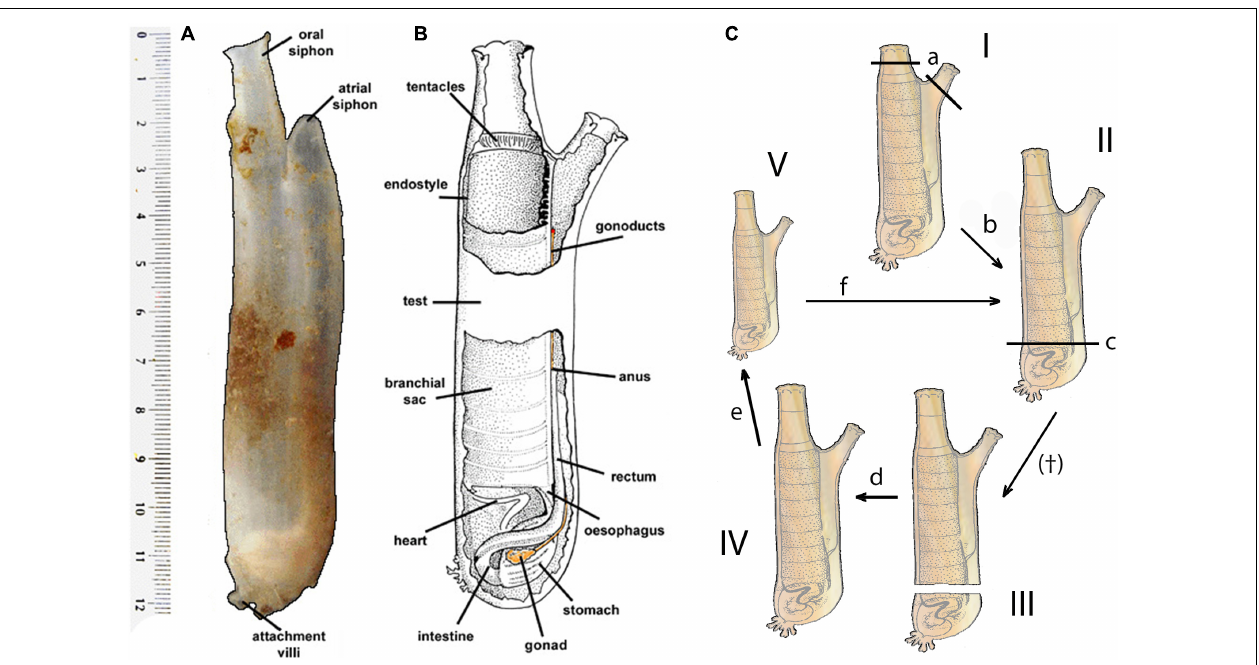
FIGURE 1 | Experiment on the inheritance of acquired character states in the sea squirt, Ciona intestinalis . To the left, external appearance and anatomy along with a cm scale (reproduced from Cirino et al., 2002, with permission) with (A) lateral view of an adult individual and (B) schematic dissection, obtained by removing part of the tubular body (“test”), showing the main anatomical structures of an adult. Gonads and gonoducts are colored. To the right, (C) sea squirt lifecycle, with a schematic representation of Kammerer’s experimental protocol (after Whittaker, 1975; Jeffery, 2015). Amputation and regeneration of both siphons resulted in animals with longer siphons (I and II), bisection of long-siphoned animals (II) allowed the distal (top) half to regenerate a gonad (III and IV), animals with regenerated gonads were crossed and produced offspring with long siphons (IV and V). Letters indicate the following events: a—siphon amputation, b—siphon regeneration, c—bisection, d—regrowth of amputated proximal part, e—fertilization and the production of offspring and f—growth and maturation. The sea squirts either reproduced as in Kammerer’s hands, or did not survive the gonad operation ( † ), as reported earlier by Hirschler (1914). Other investigators were unable to obtain